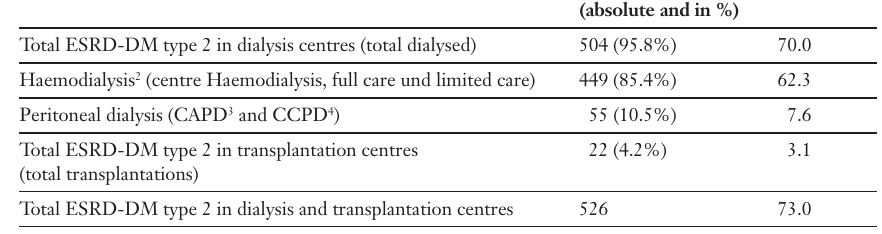
Total ESRD in type 2 DM (dialysis and transplantation cen- tres); classification into the three modes of therapies (ab- solute and in %) and